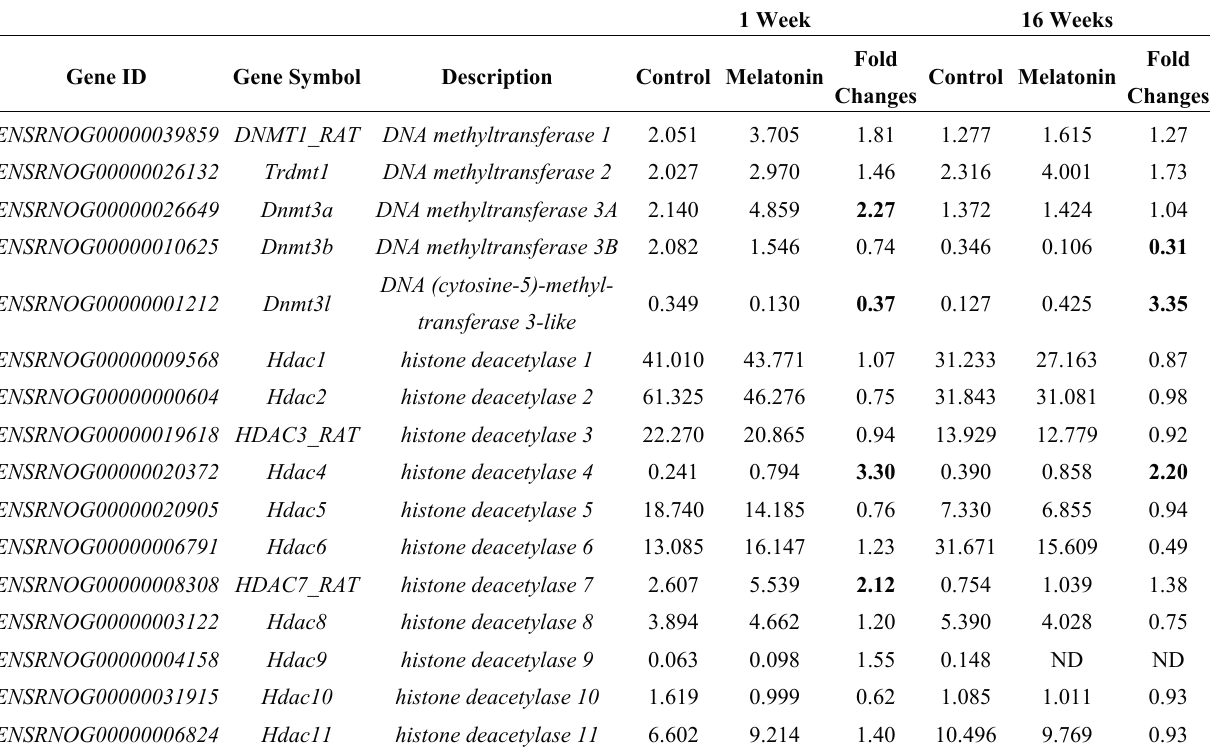
Table 2. Changes of epigenetic regulator genes in the kidney of melatonin-treated offspring vs. control at one week and 16 weeks of